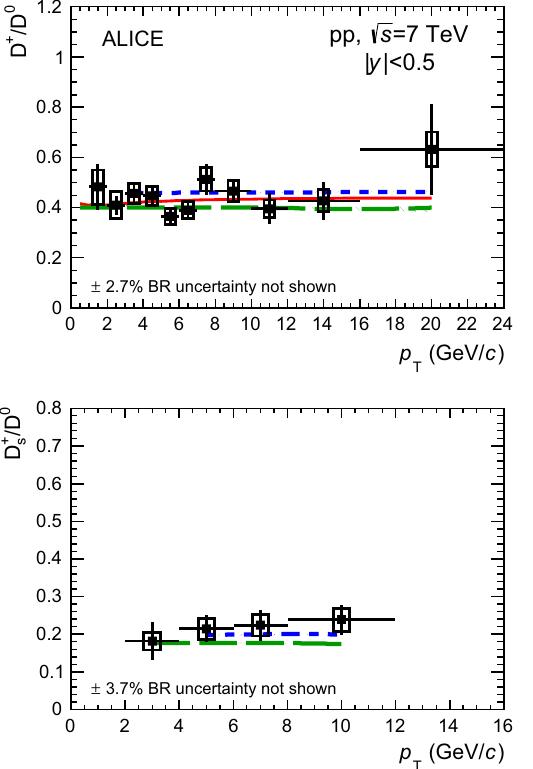
LHCb measurement were multiplied by 2 to refer them to one unit of rapidity. The error bars represent the total (statistical and systematic) uncertainty on the measurement. Predictions from FONLL calculations are compared to the data points